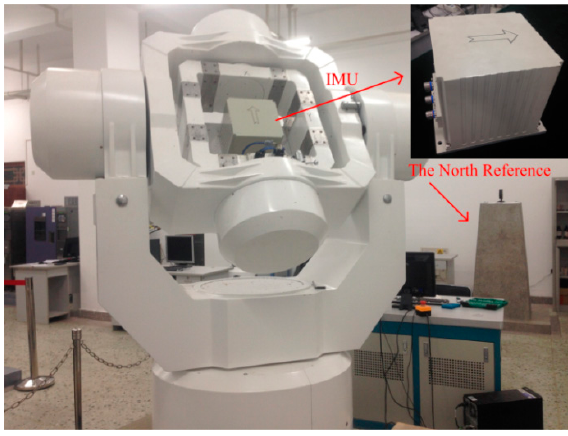
Figure 9. The IMU and turntable.